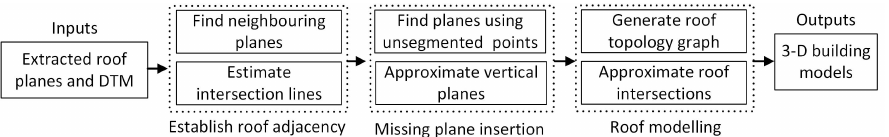
Figure 1. The workflow of the proposed 3-D building modelling